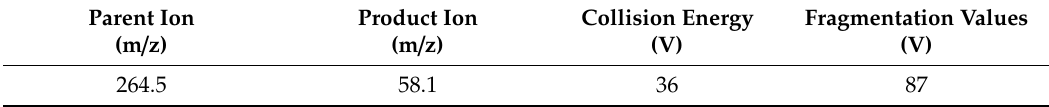
Table 1. LC / ESI / MS / MS analysis parameters for tramadol hydrochloride in water